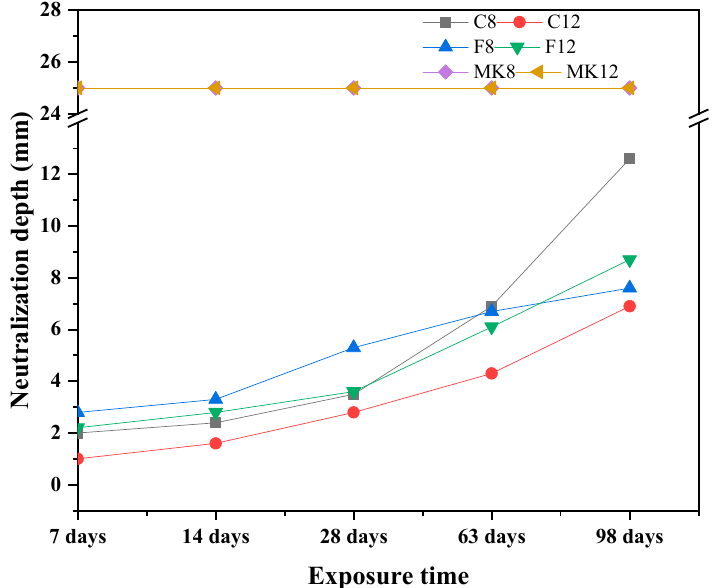
Figure 4. Neutralization depth of different GPCs exposed to sulfuric acid solution.